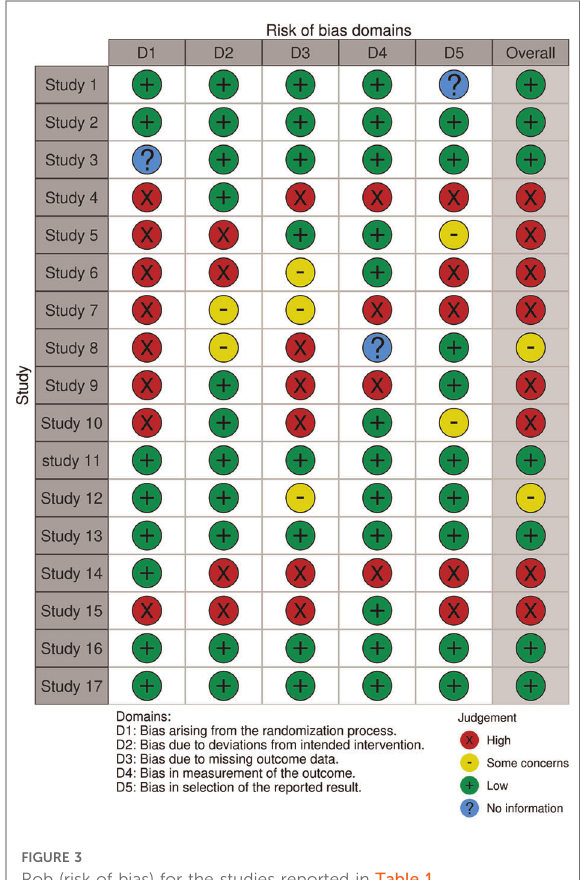
FIGURE 3 Rob (risk of bias) for the studies reported in Table 1